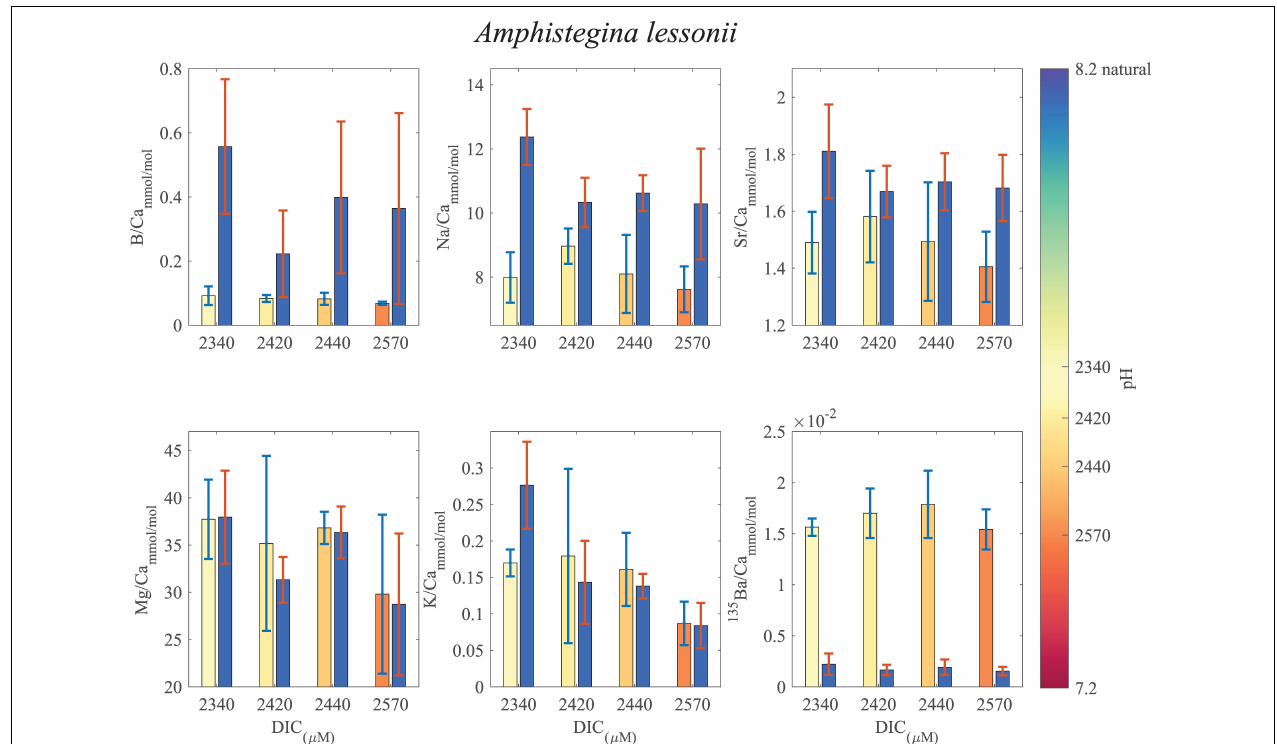
FIGURE 8 | Averages of El/Ca ratios of the natural-original shells Amphistegina lessonii in comparison with the newly grown shell under the DIC modified experimental conditions. For B/Ca, Na/Ca and Sr/Ca the new shell ratios are significantly lower than the original shell. For K/Ca and Mg/Ca the new shells show ratios that are variable, slight lower or similar to the original shell (see Tables 1 , 2 for statistics). 135 Ba/Ca show the enrichment of the 135 Ba that was added to the culture media to mark the newly precipitated calcite. The numbers on the colored pH bar represent the experimental average DIC measurements during the experiments.